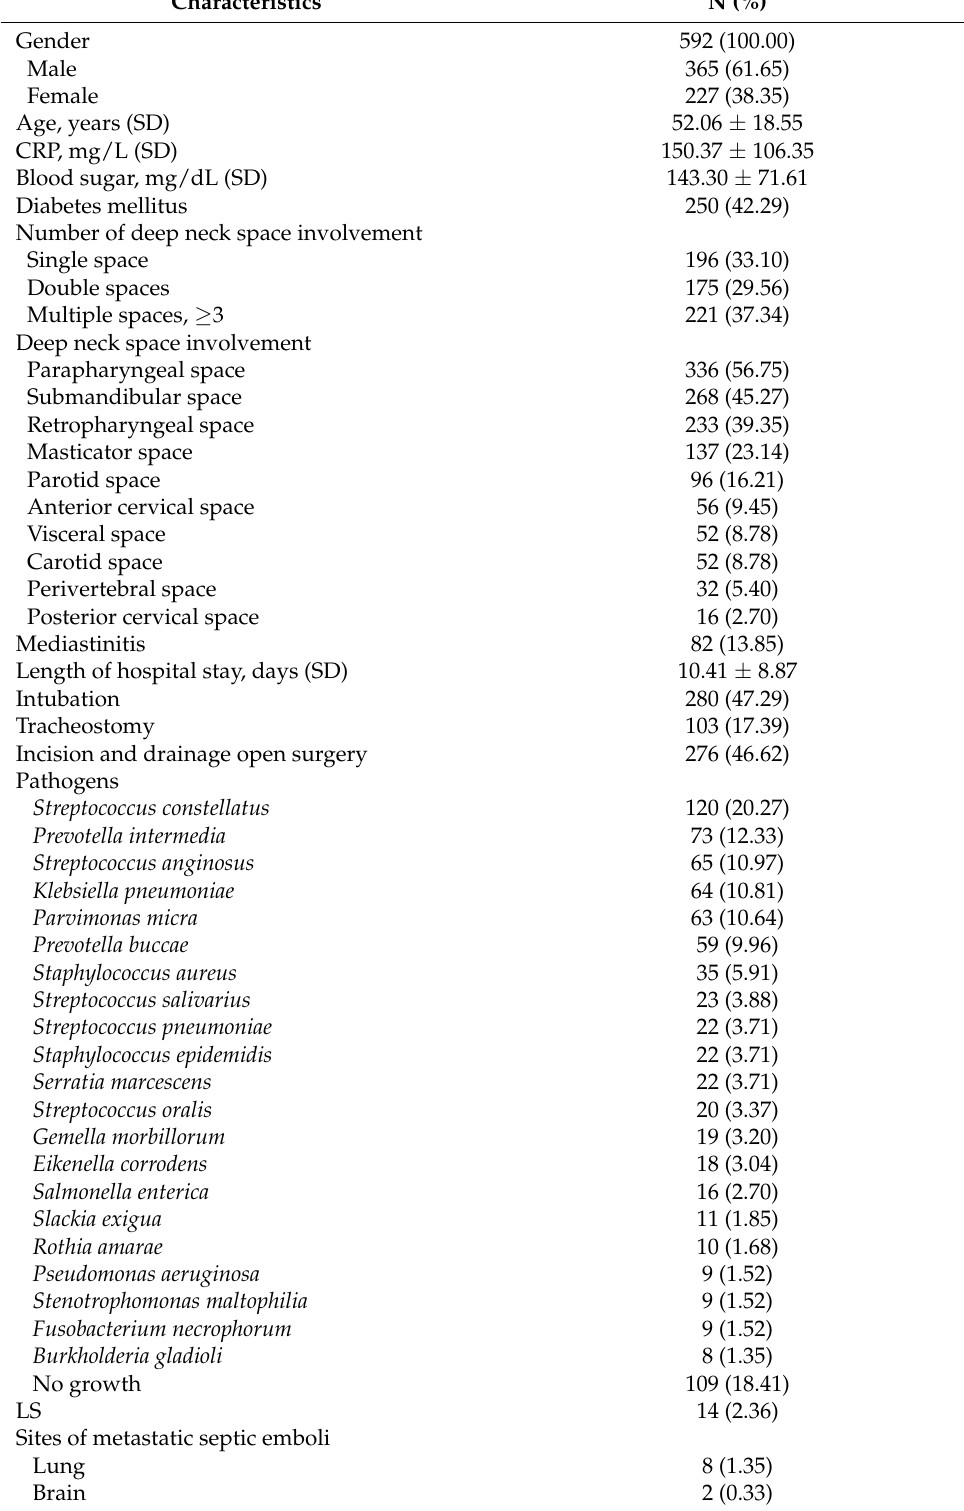
Table 1. Clinical characteristics of 592 patients with